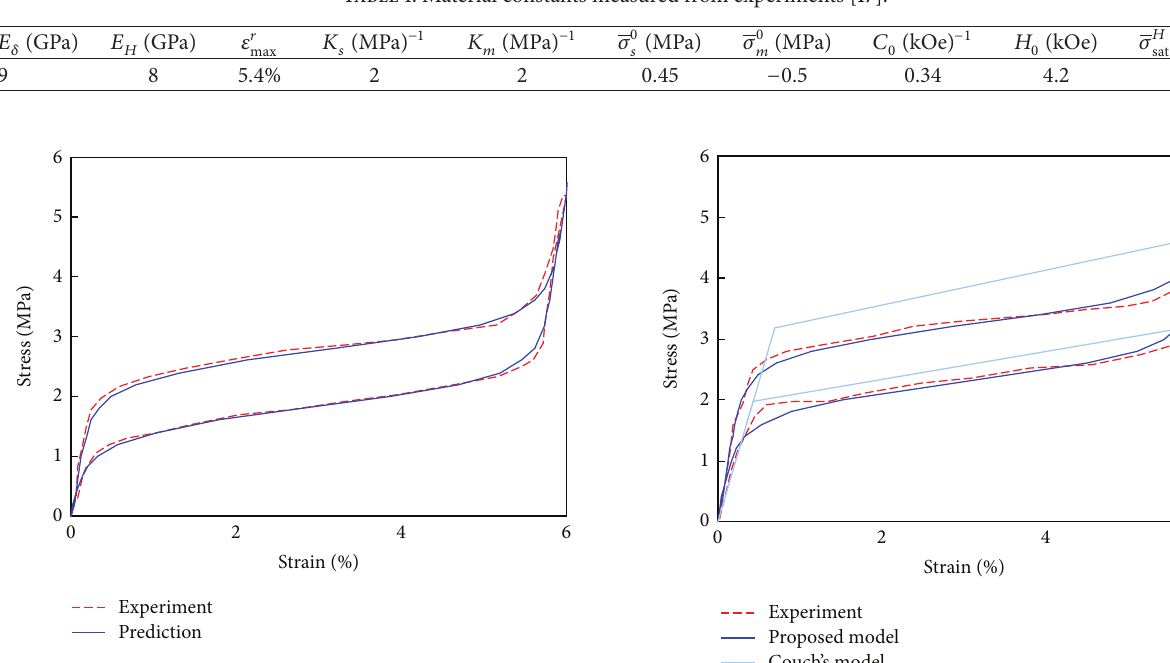
Figure 2: Pseudoelasticity of magnetic shape memory alloy in martensite at 6kOe. The prediction is compared with experimental data from [17].